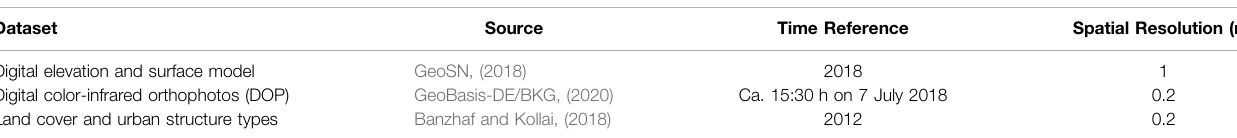
TABLE 1 | Datasets used as predictors for spatially-explicit air temperature